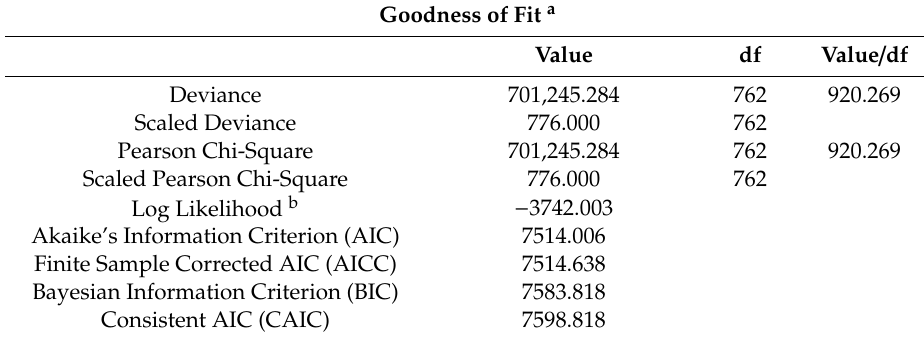
Table A5. Goodness of Fit Tests for the Model.